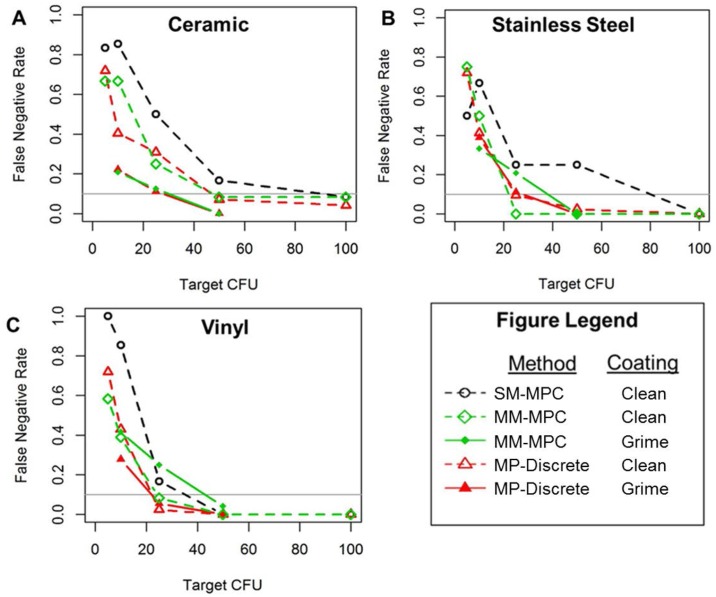
The FNR for the MM-MPC and MP-Discrete methods are similar for grime coated and clean coupons.The highest FNR were associated with the SM-MPC method. FNR decreases as CFU increases, and is consistently lowest at 100 CFU for ceramic (A), stainless steel (B), and vinyl (C) surfaces that are either clean or grime coated. The gray line in each plot demarcates the 0.1 FNR threshold (i.e., LOD90). The CFU targets used were 5, 10, 25, 50, and 100 CFU per coupon. Coupons were contaminated in four or eight locations for the SM-MPC and MM-MPC methods.